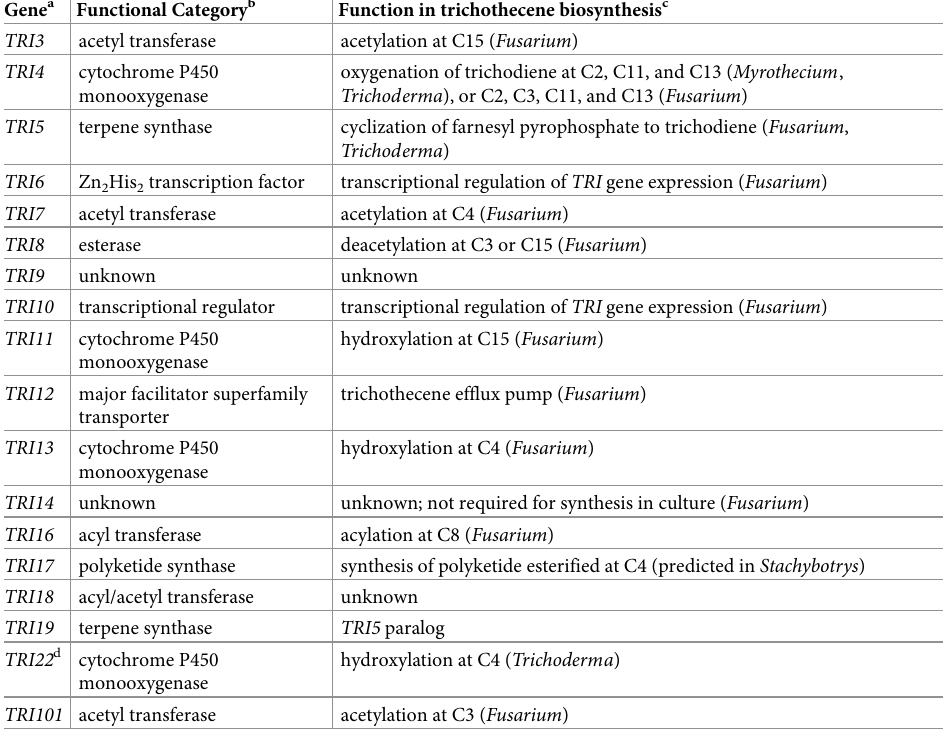
Table 1. Functions of trichothecene biosynthetic